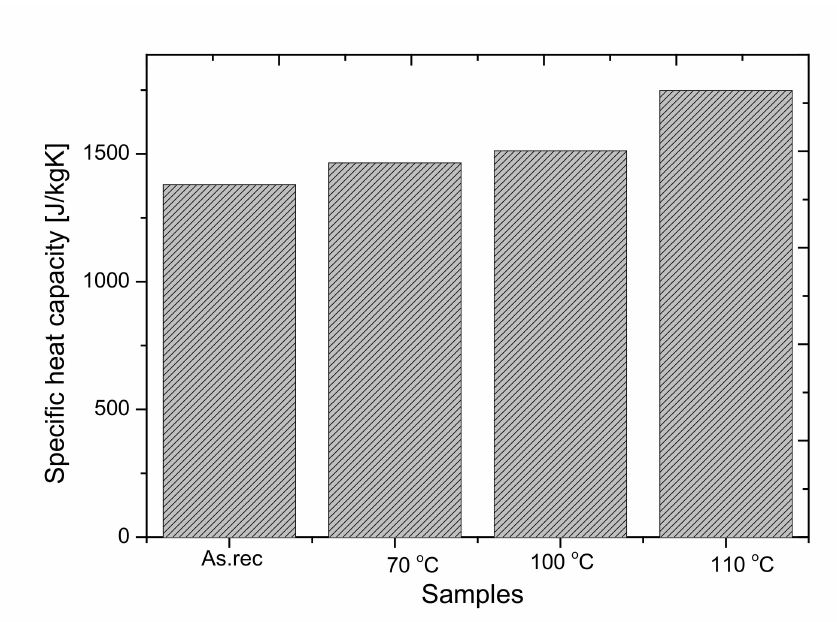
Figure 8. The specific heat capacities of the samples at 25 ◦ C.